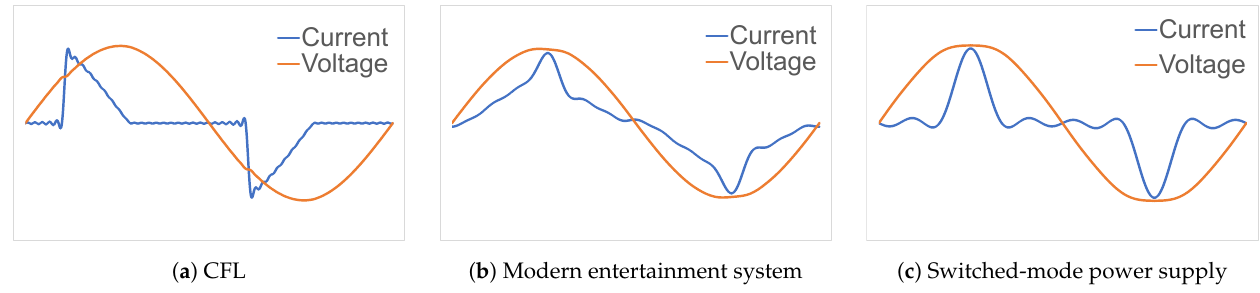
Figure 2. Real-world current signal tests